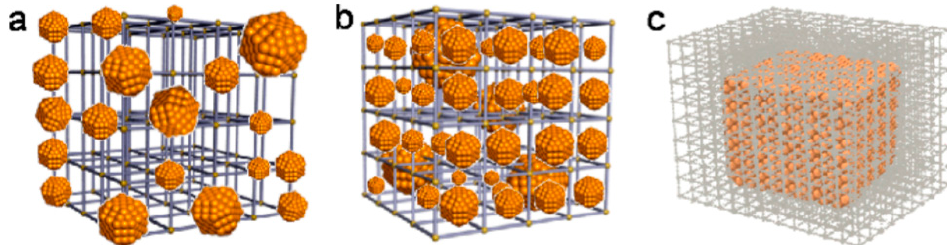
Figure 10. Representative methods of preparation of composites consisting of metal nanoparticles and MOF. ( a ) A solid grinding method. ( b ) The solution infiltration. ( c ) An encapsulation of presynthesized nanoparticles by growing the MOF around them. Reprinted with permission from [158]. Copyright © 2016, American Chemical Society. All rights reserved.